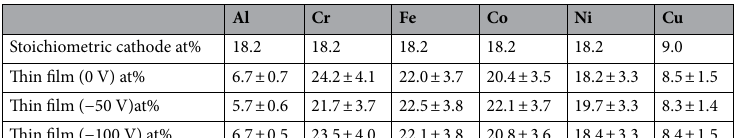
Al Cr Fe Co Ni Cu Stoichiometric cathode at%